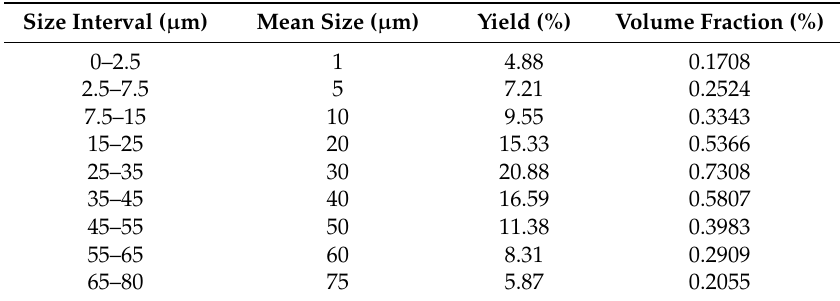
Table 2. The size distribution of particles in the feed.